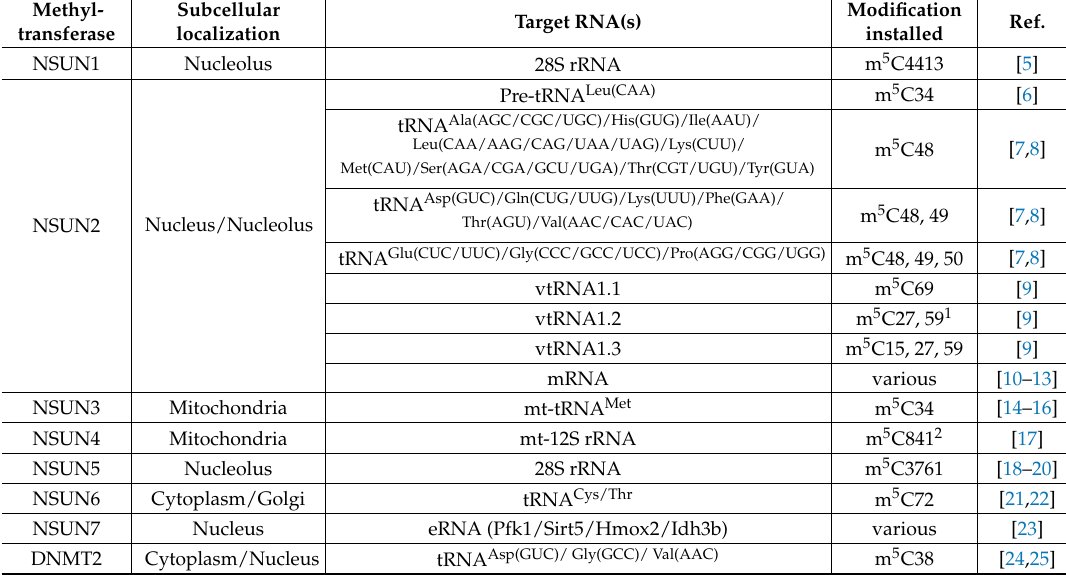
Table 1. Overview of human m 5 C methyltransferases and their RNA targets. Abbreviations: ribosomal RNA – rRNA, transfer RNA – tRNA, mitochondrial – mt, enhancer RNA –